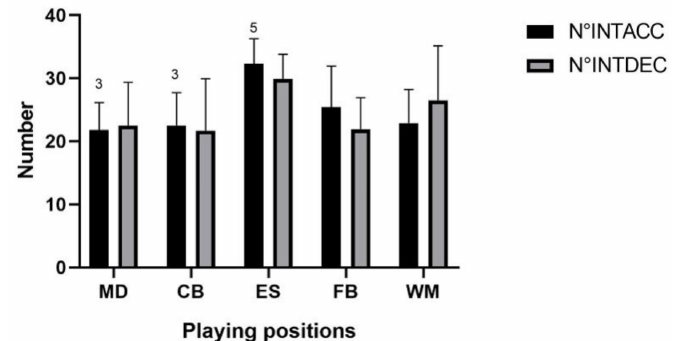
Figure 2. Playing position’s mechanics indicators (N ◦ INTACC, N ◦ INTDEC) during the first half of official matches. Legend: N ◦ INTACC, Number of Intense Accelerations; N ◦ INTDEC, Number of Intense Decelerations; p < 0.05 for differences between playing positions (3 difference with external striker; 5 difference with wide midfielder).